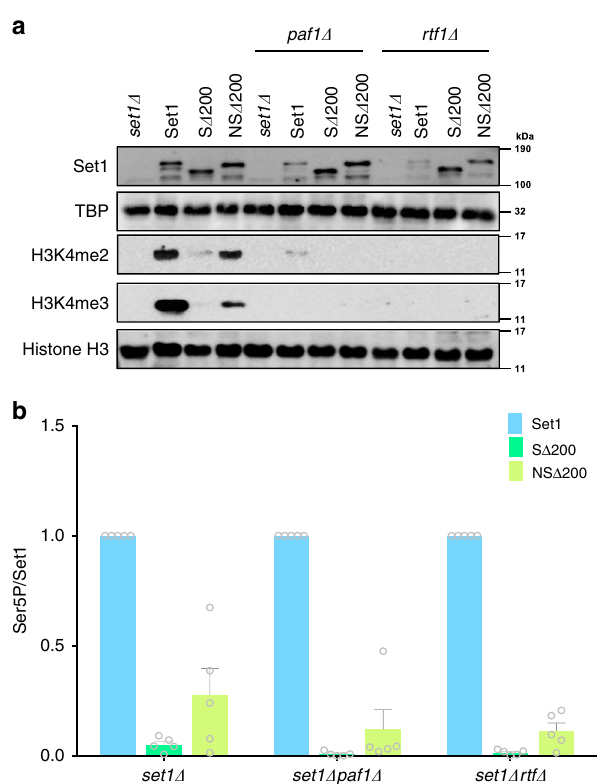
Fig. 6 Nrd1CID – Set1 Δ 200 fusion does not bypass the role of Paf1C and H2Bub in H3K4me. a Wild-type Set1 (Set1), Set1 Δ 200 (S Δ 200), and Nrd1CID – Set1 Δ 200 (NS Δ 200) were transformed into set1 Δ , set1 Δ paf1 Δ , or set1 Δ rtf1 Δ cells. Protein levels and histone methylations in whole-cell extracts were analyzed by immunoblotting. TBP and Histone H3 were used as loading controls. Parallel experiments in set1 Δ bre1 Δ cells showed the same loss of H3K4 methylation (Supplemental Fig. 6a). b Set1 association with RNApII was quantitated by immunoprecipitating Set1 using α -FLAG beads and probing for Rpb1 CTD Ser5P and Set1. Set1 and Ser5P signal intensities from each immunoblot were quantitated using ImageJ, and Ser5P signals were normalized to those for Set1. Circles show individual experimental values, and error bars show s.e.m. ( n = 5). Values from wild type Set1 transformants were normalized to 1.0 for each experiment. Source data are provided as a Source data fi